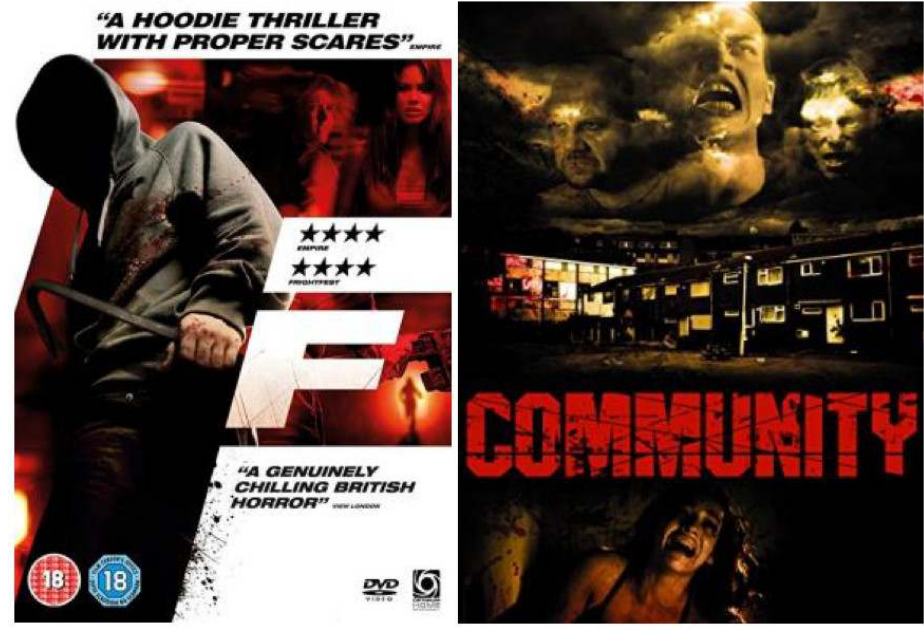
Figure 1. Animals and